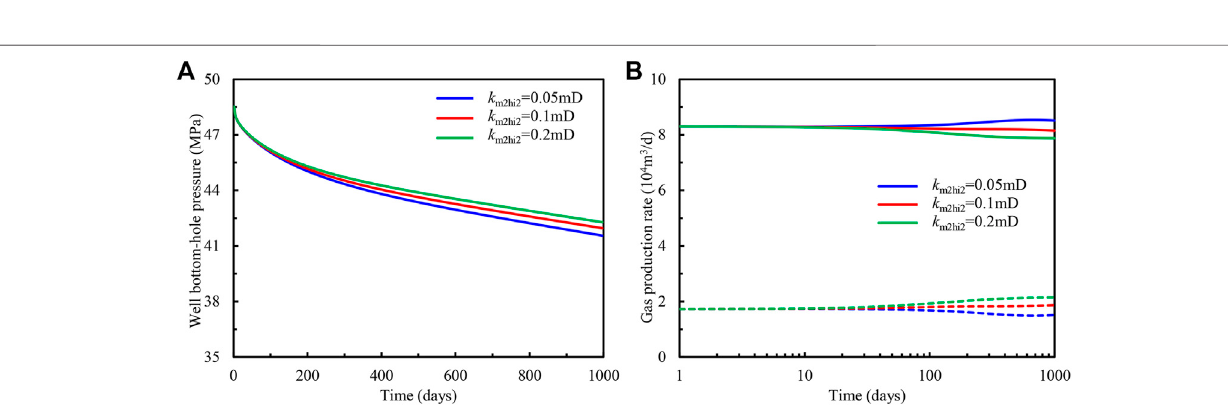
Frontiers in Energy Research |